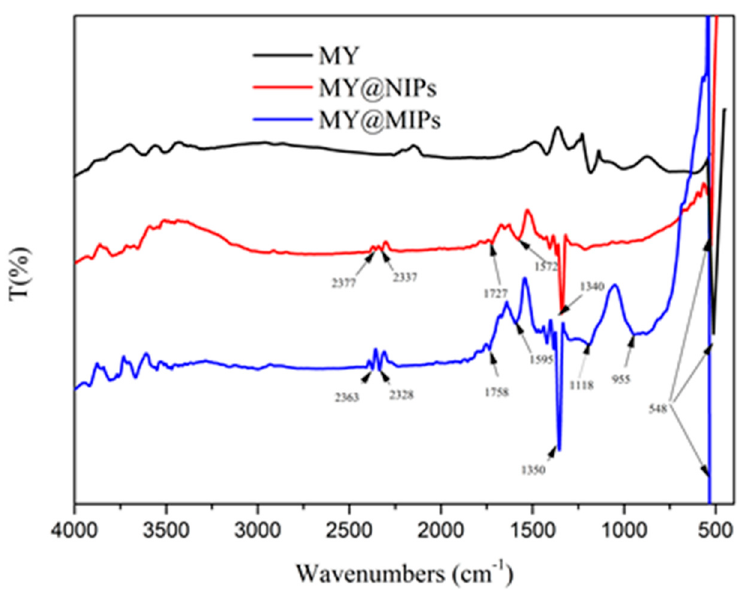
Figure 2. FTIR spectra of magnetic yeast (MY), magnetic yeast-molecularly imprinted polymers without